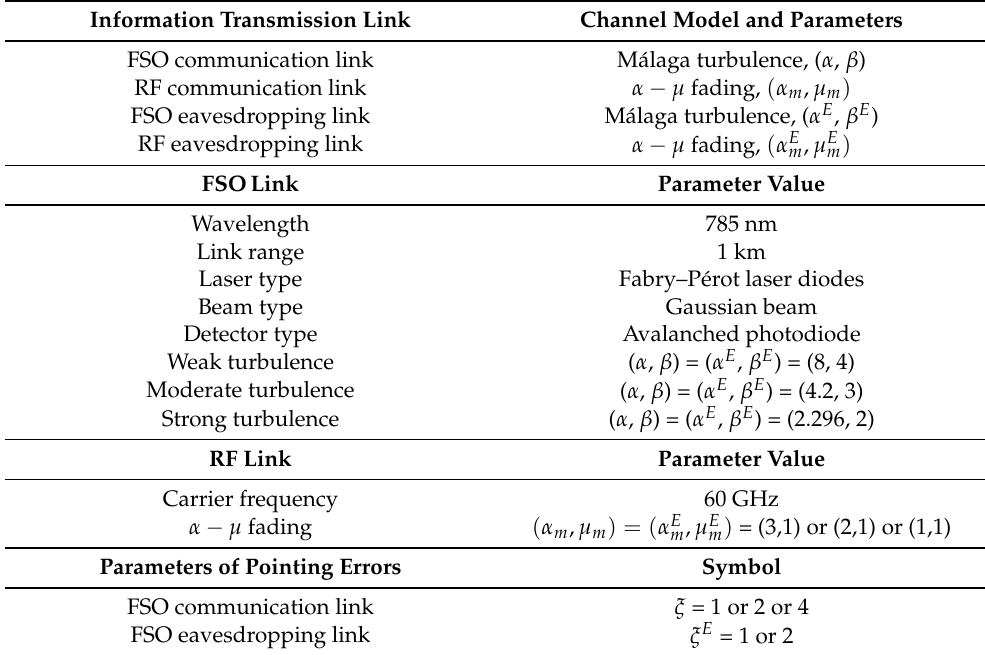
Table 3. Simulation parameters of the hybrid FSO/RF with